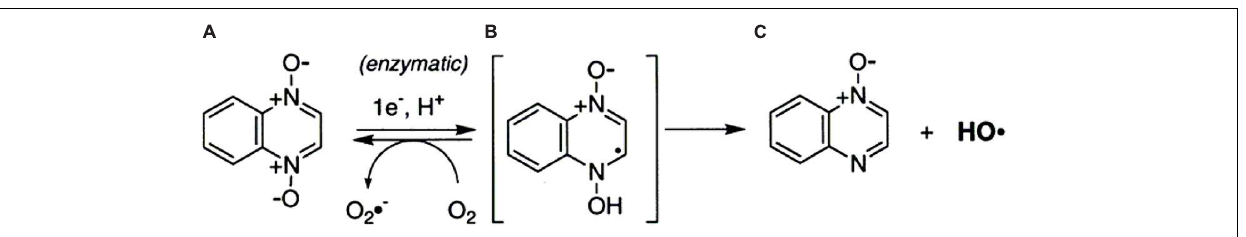
FIGURE 2 | One-electron reduction of quinoxaline 1,4-dioxide by reductase (Ganley et al.,